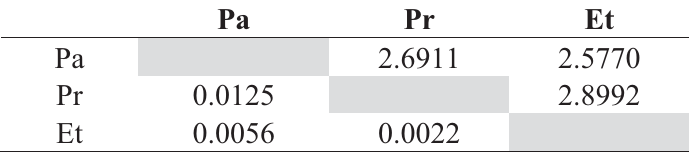
Table 4. Codon-based test of positive selection for analysis between percid CENP-A sequences (Pa: P. austroperka , Pr: P. roanoka , and Et: E. tallapoosae ). The probability of rejecting the null hypothesis of strict-neutrality (dN = dS) in favor of the alternative hypothesis of positive selection (dN > dS) at the middle portion of the N-terminal tail (Figure 4, red underlined sequences) is given below the diagonal. Values of less than 0.05 are considered significant. The test statistic (dN – dS) is shown above the diagonal.